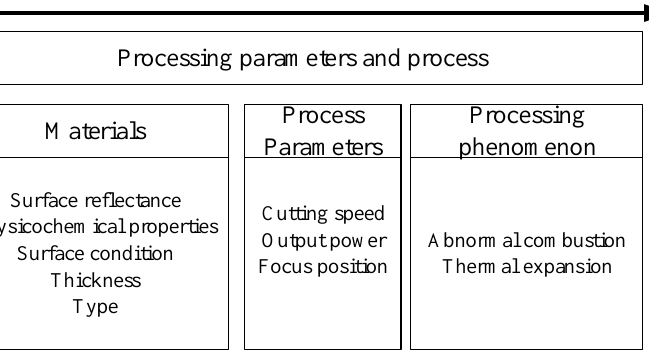
Figure 1. Factors affecting laser cutting accuracy.